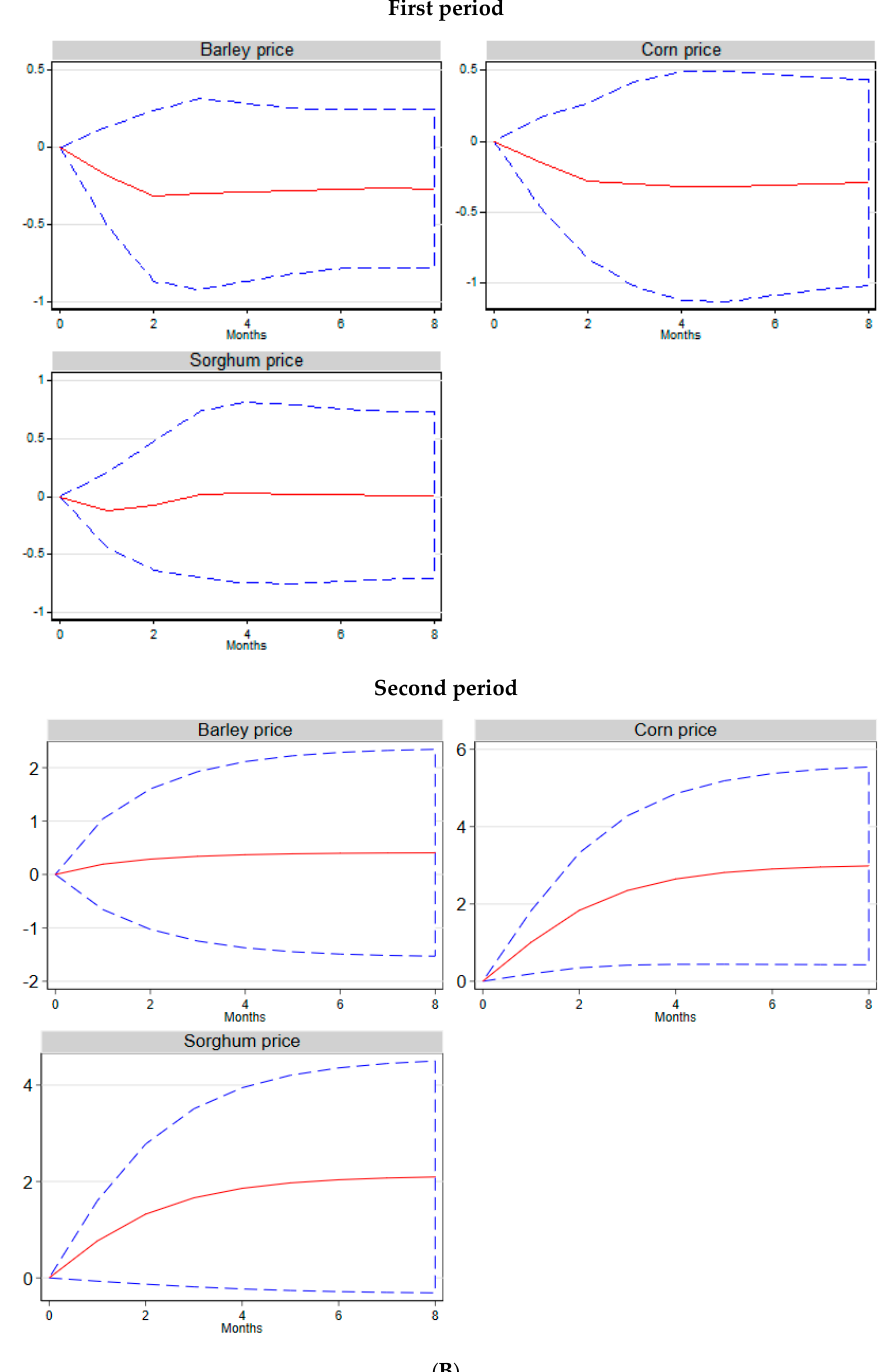
Figure 1. ( A ) Response of agricultural commodity prices to oil-specific demand shocks; ( B ) response of oil price to agricultural related-shocks. Notes: Red lines represent cumulative orthogonalized impulse–response functions while blue lines represent 95% confidence intervals.